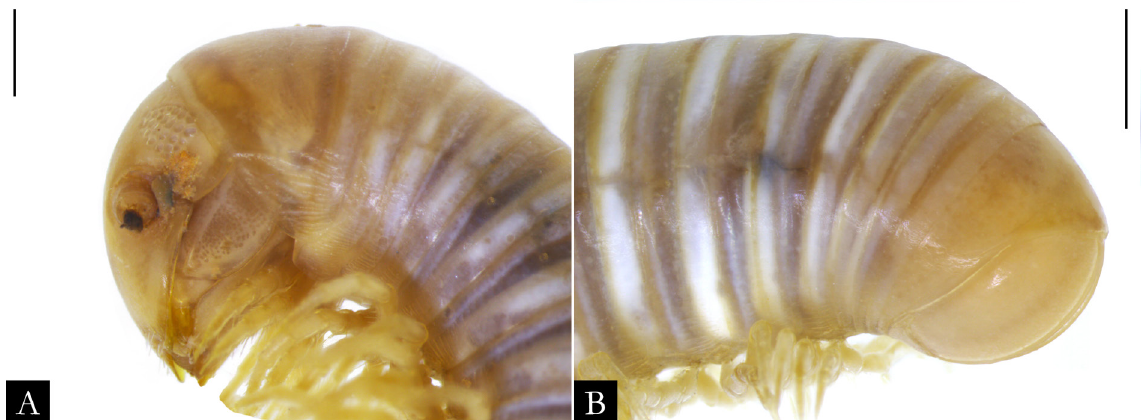
Fig. 46. Pseudonannolene ambuatinga Iniesta & Ferreira, 2013, paratype, ♀ (ISLA 2274), in lateral view. A . Anterior region. B . Posterior region. Scale bars: A = 0.5 mm; B = 1